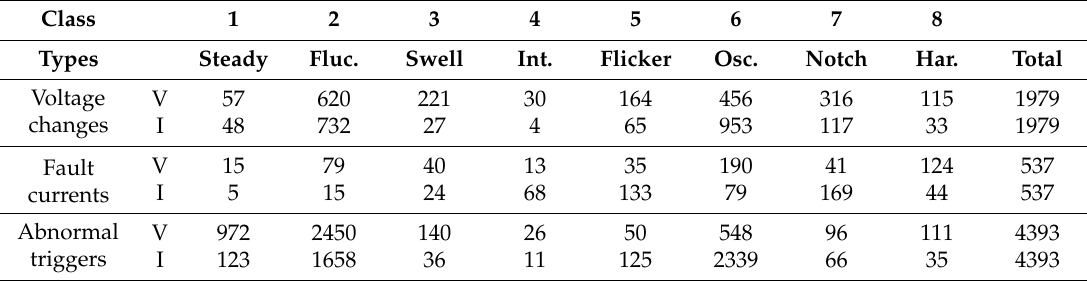
Table 2. Numbers of classified waveforms regarding acquisition types by FRTUs and PMUs.